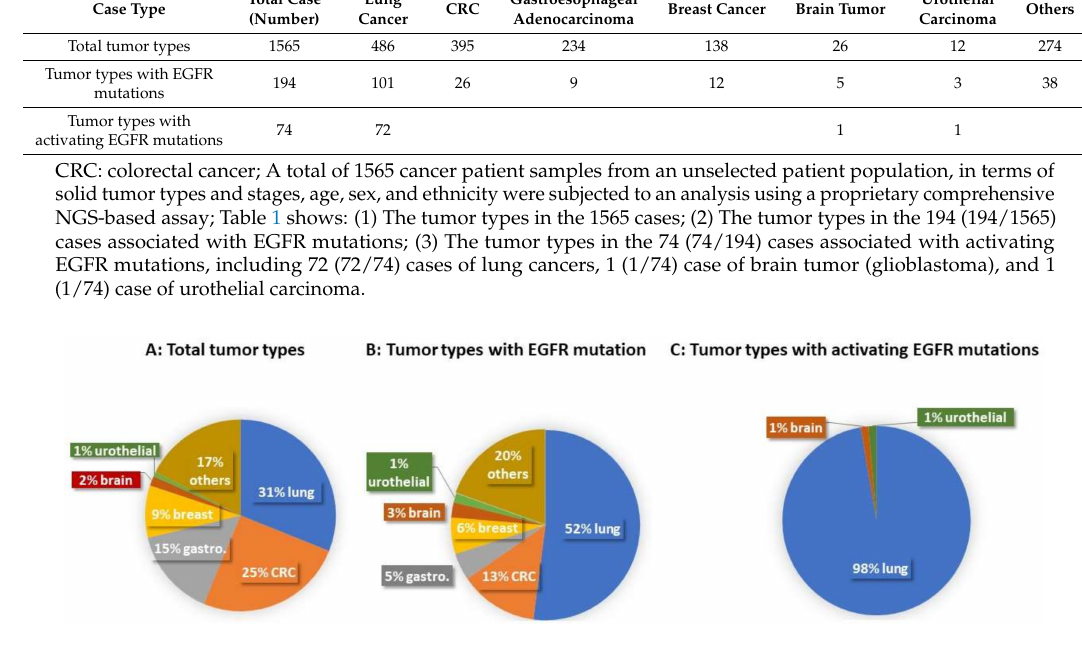
Figure 1. Tumor Types and Distribution of EGFR Mutations. Figure 1 is based on Table 1.